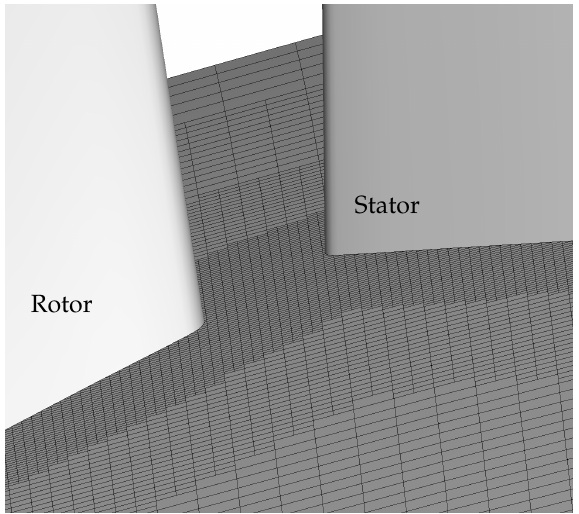
Figure 10. A close view to the 5-level mesh on the hub surface at g = 10% d 0